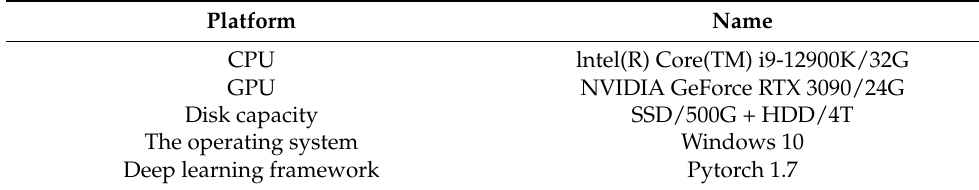
Table 3. Experimental platform.